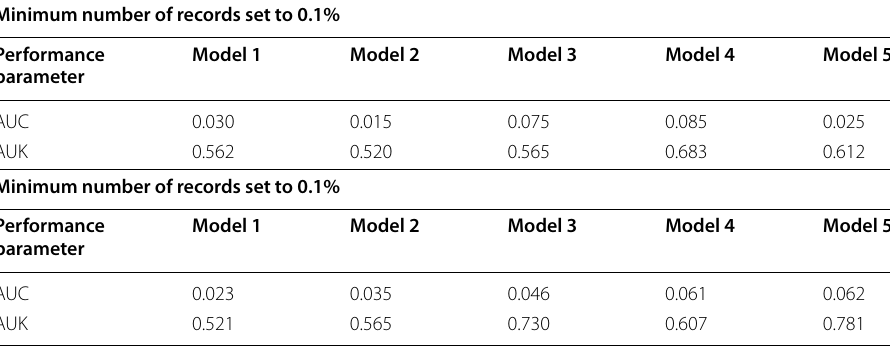
Table 2 Decision tree models performance parameters Minimum number of records set to